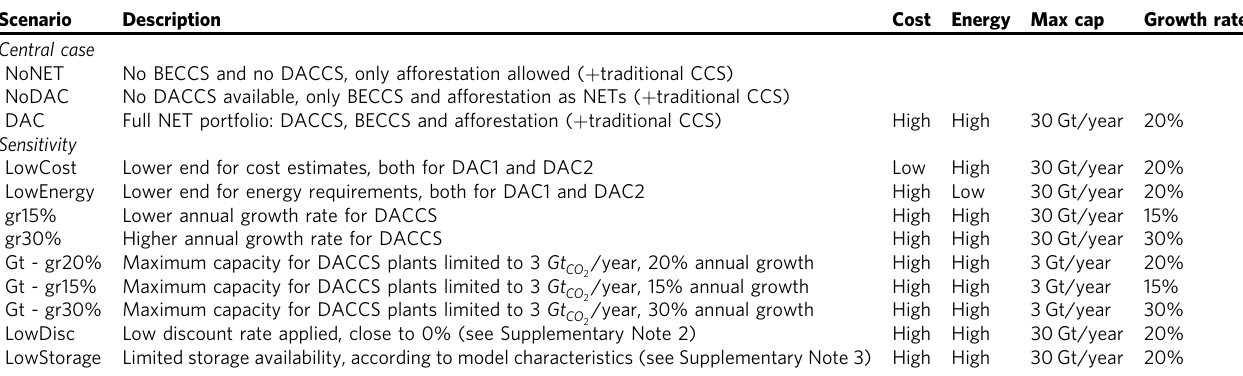
Table 1 Scenario overview